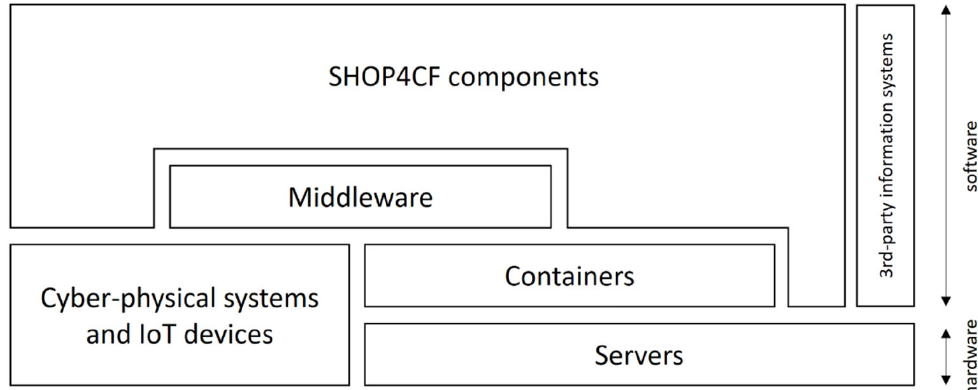
Figure 3. Top-level logical platform architecture [32]. The platform is composed of different levels depending on closeness to the hardware. On the top level are the SHOP4CF components along with third-party information systems, which are software components meant to use data to send and receive information. On the middle level, middleware, containers, and software of cyber-physical systems, which are components related to moving data between hardware and software, are positioned. On the bottom level there are hardware components such as servers and IoT devices meant to perform environment changes.